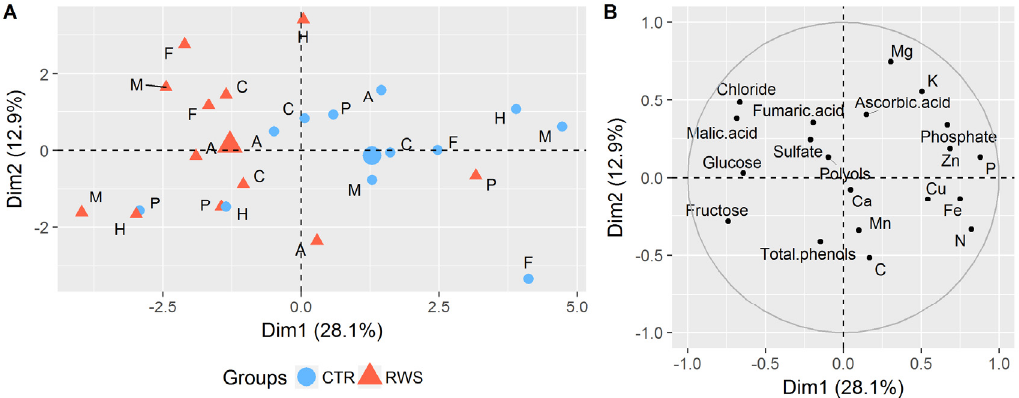
Figure 3. Multivariate evaluation by PCA (PC1 + PC2) of the total cucumber dataset including both picking sets (week 28 and week 29) based on dry matter-data. Score plot ( A ) represents all individual plot samples (marked by the letters A, C, F, H, M, and P) classified according to the control CTR (blue circles) and reduced water supply RWS (red triangles). The corresponding loading plot ( B ) shows the related variables as determined by chemical analyses.